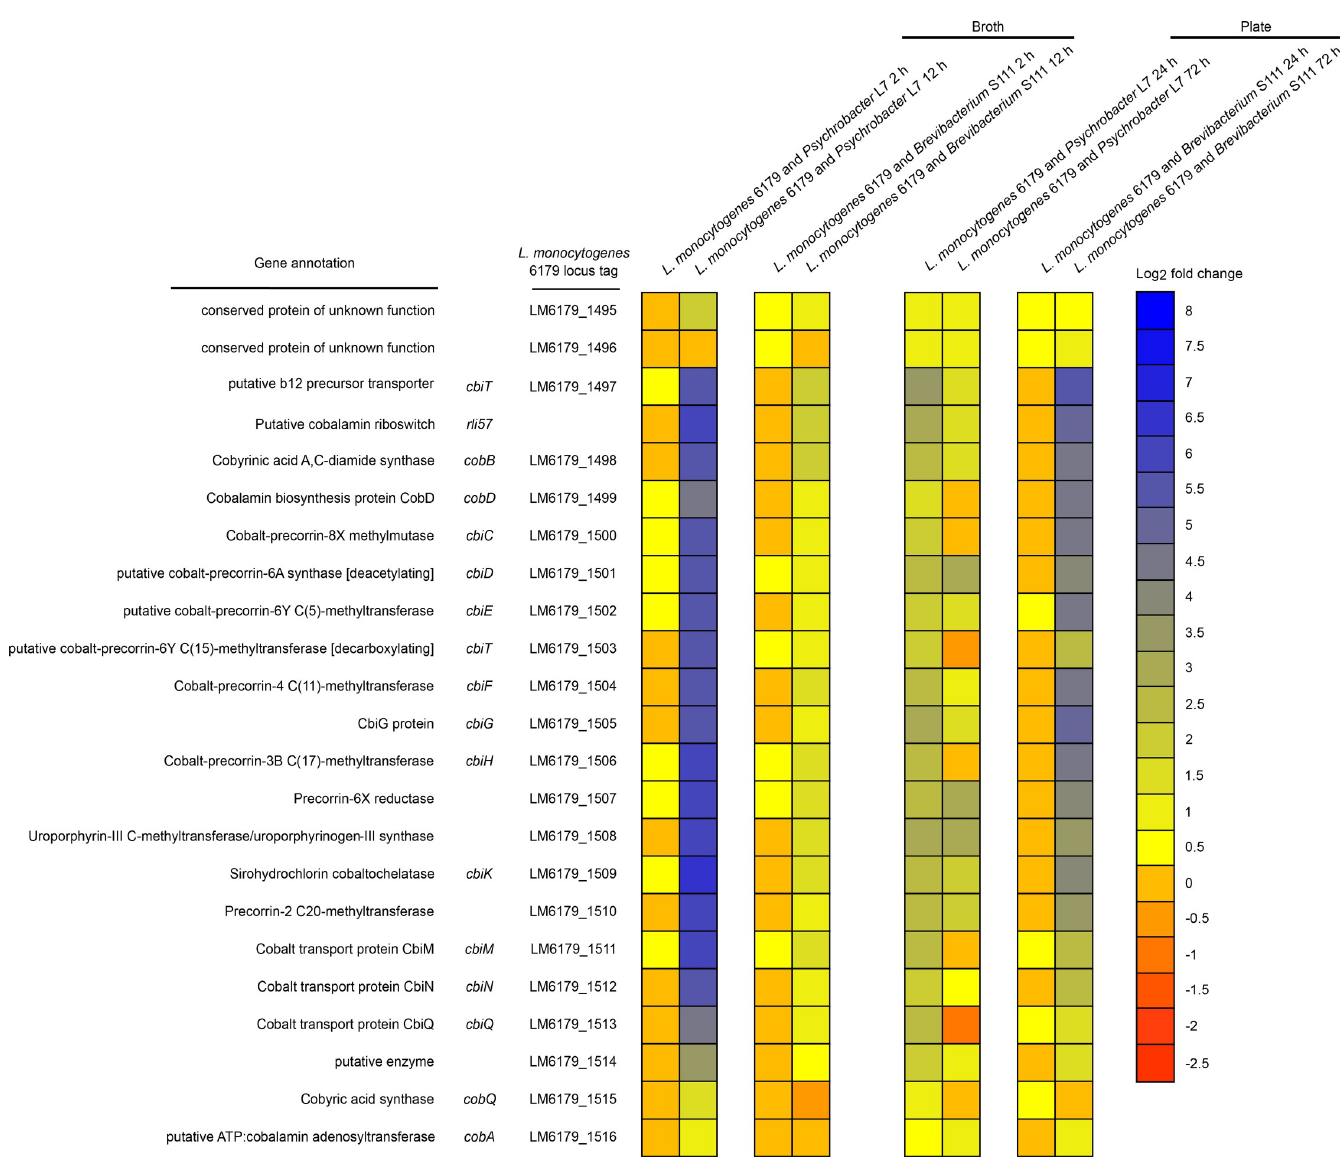
Fig 4. Heatmap showing the gene expression of the L . monocytogenes cob/cbi module, which is involved in the production of cobalamin derivatives, during co- cultivation with Brevibacterium S111 and Psychrobacter L7 in broth and on plates. Colors represent the log2 fold change in gene expression corresponding to each co-culture condition compared to the monoculture control and the respective cob/cbi module gene. Please see S1 and S2 Tables for more details regarding gene expression patterns, including q-values and log2 fold changes.